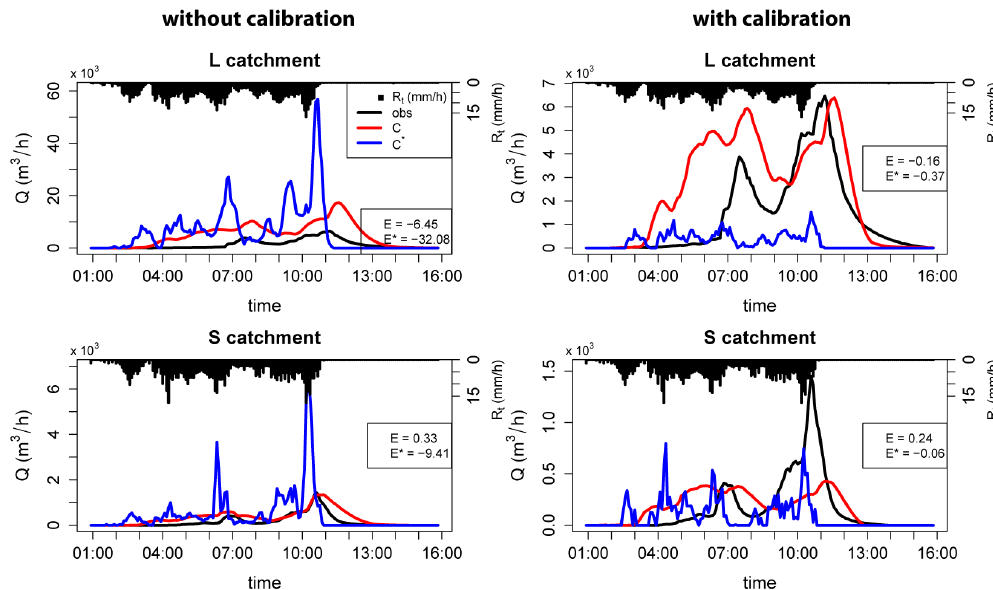
Fig. A3. Same as in Fig. A1, for an event on 7 September 2010. Note that observed discharge in the M catchment is not available for this event.